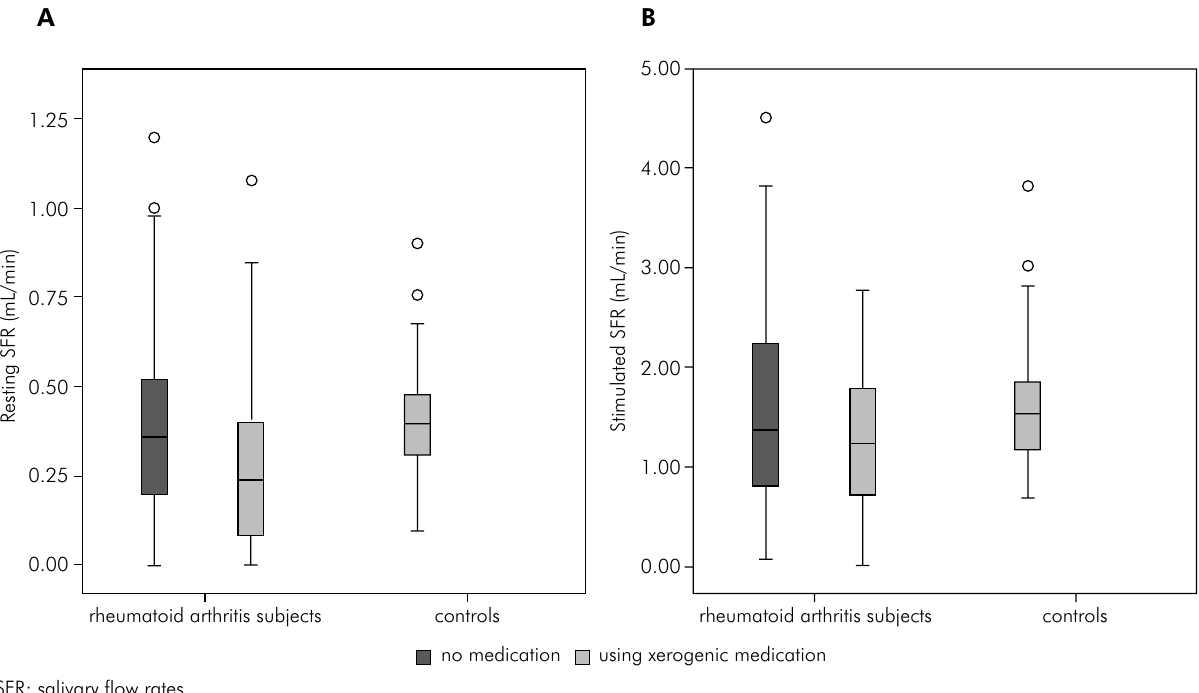
Figure 2. Box plot graph of the resting (A) and stimulated (B) salivary flow rates of the 145 studied subjects separated by group and the use of xerogenic